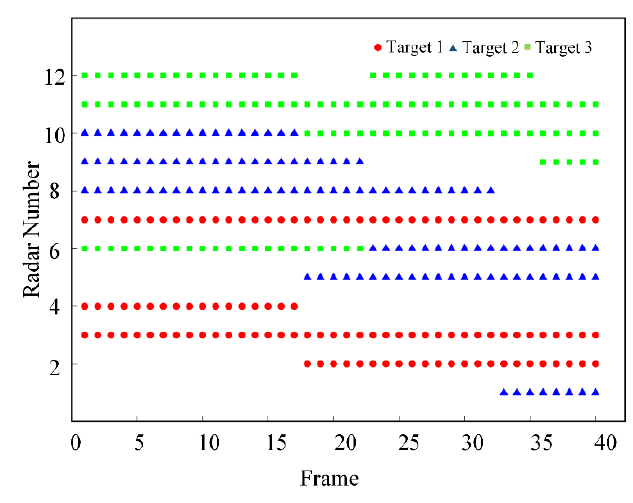
Figure 8. Radar clustering at each moment.